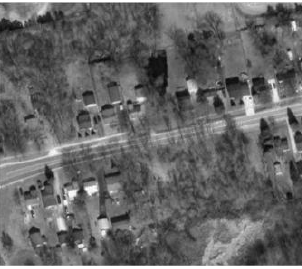
Figure 2: Non-Salient road